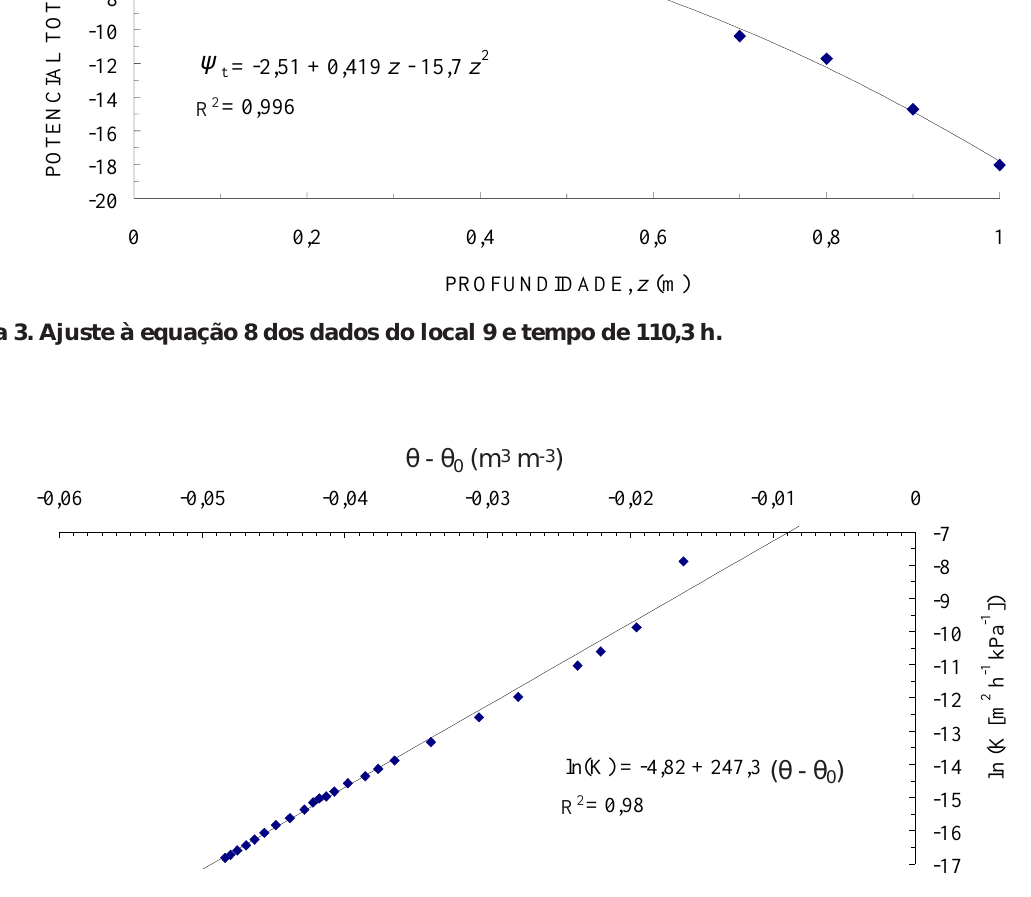
Figura 4. Ajuste à equação 10 dos dados do local 9 e profundidade de 0,8